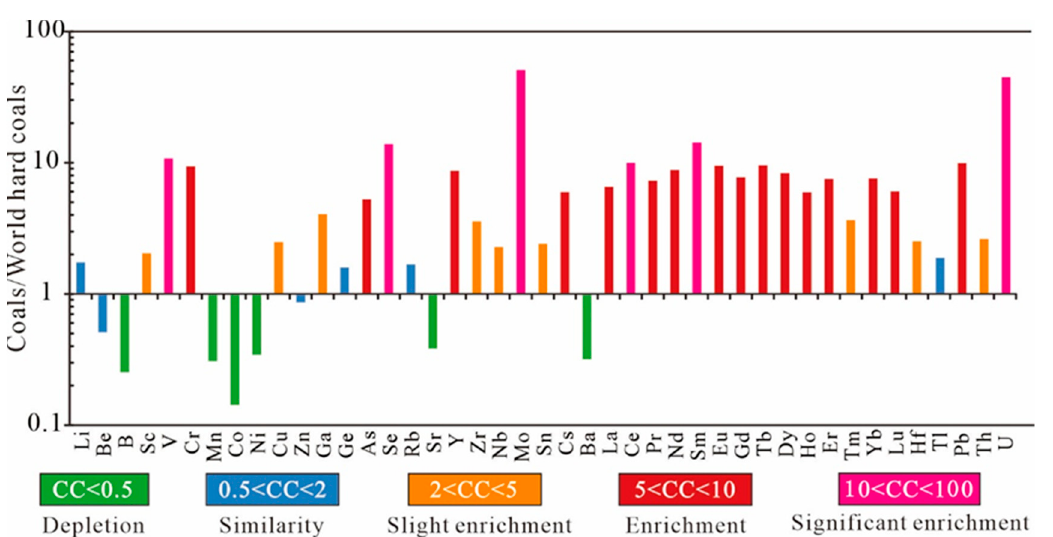
Figure 6. Concentration coefficient (CC) of trace elements in the studied coals, normalized to the respective average of world hard coals [28].